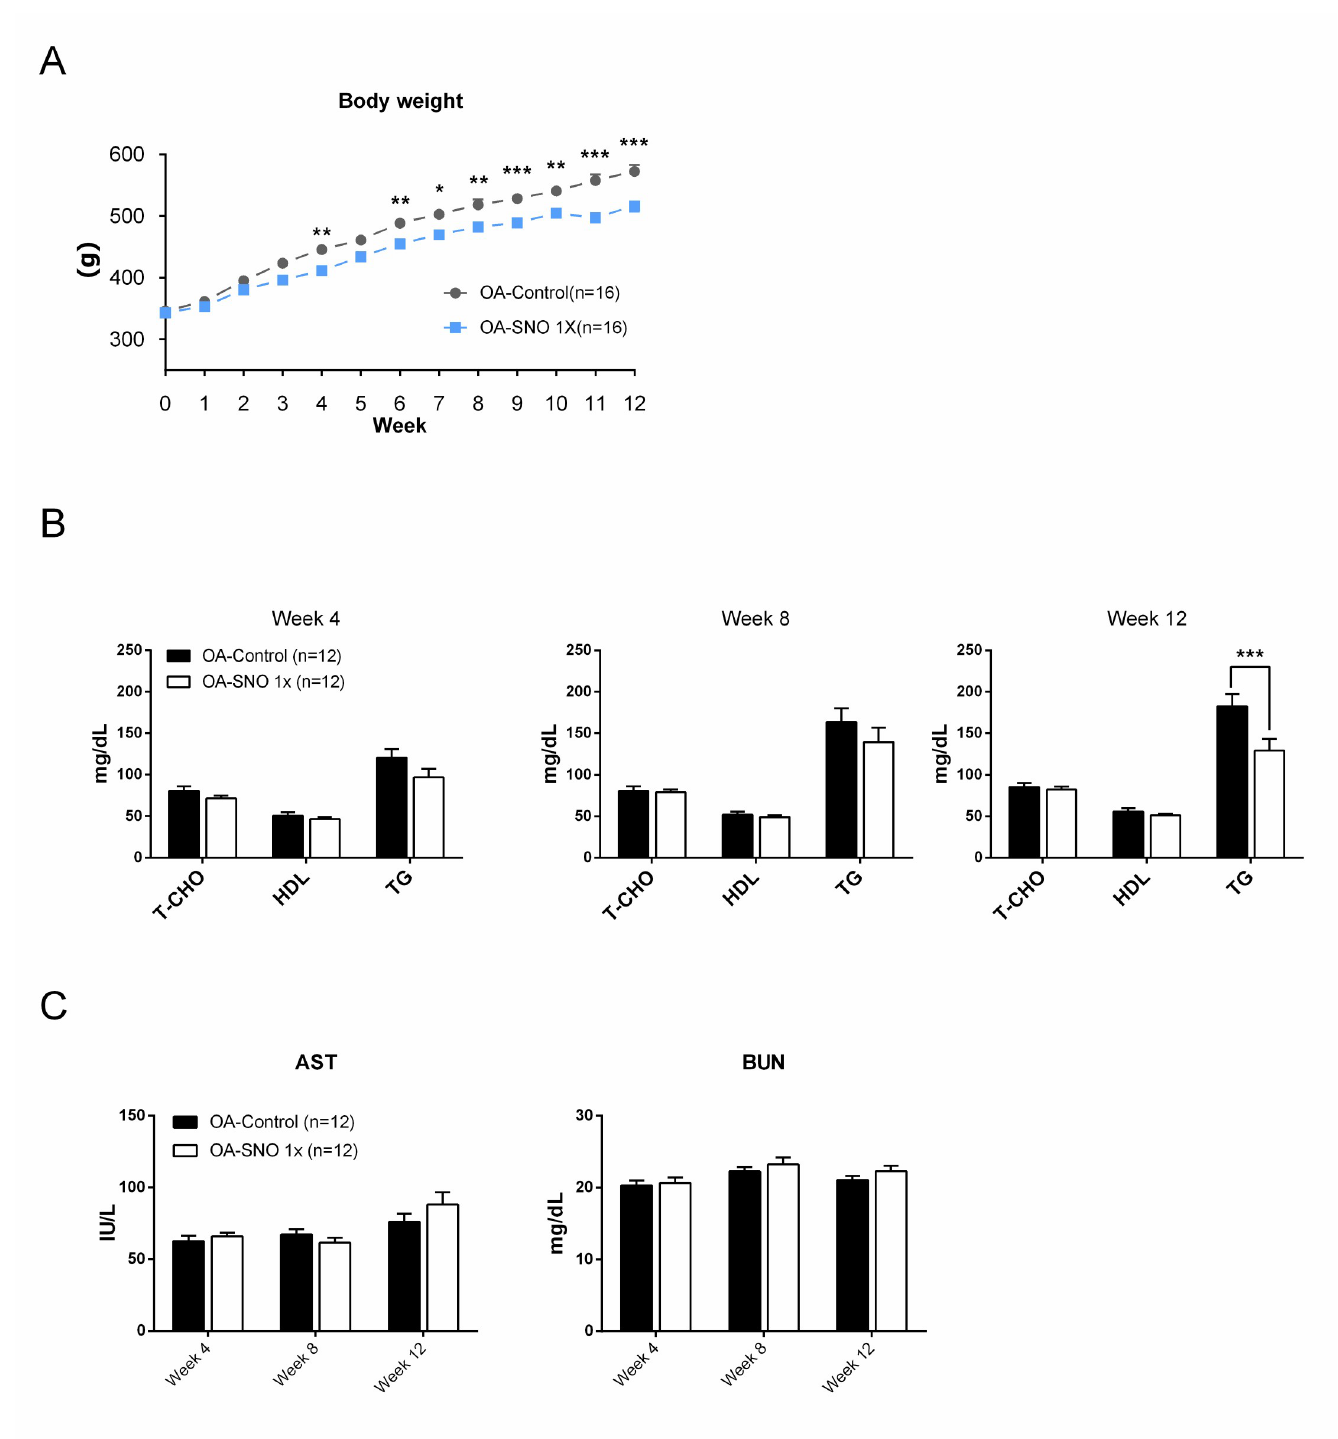
Fig 5. Time-course changes in the serum chemistry, lipid profile and body weight. (A) Body weight changes from 0–12 weeks in the OA-control and OA-SNO 1X rats. (B) Total cholesterol (T-CHO), HDL and triglyceride (TG) levels at weeks 4, 8 and 12 after ACLT+MMx surgery. (C) Time-course analysis of the serum AST and BUN levels in both the OA-control and OA-SNO 1X groups. Values are expressed as the mean ± S.E.M. and two-way ANOVA and Sidaks’s multiple comparisons test were used to analyze the data. Asterisks denote significant differences compared to the OA-control rats: � P < 0.05, �� P < 0.01, ��� P < 0.001.